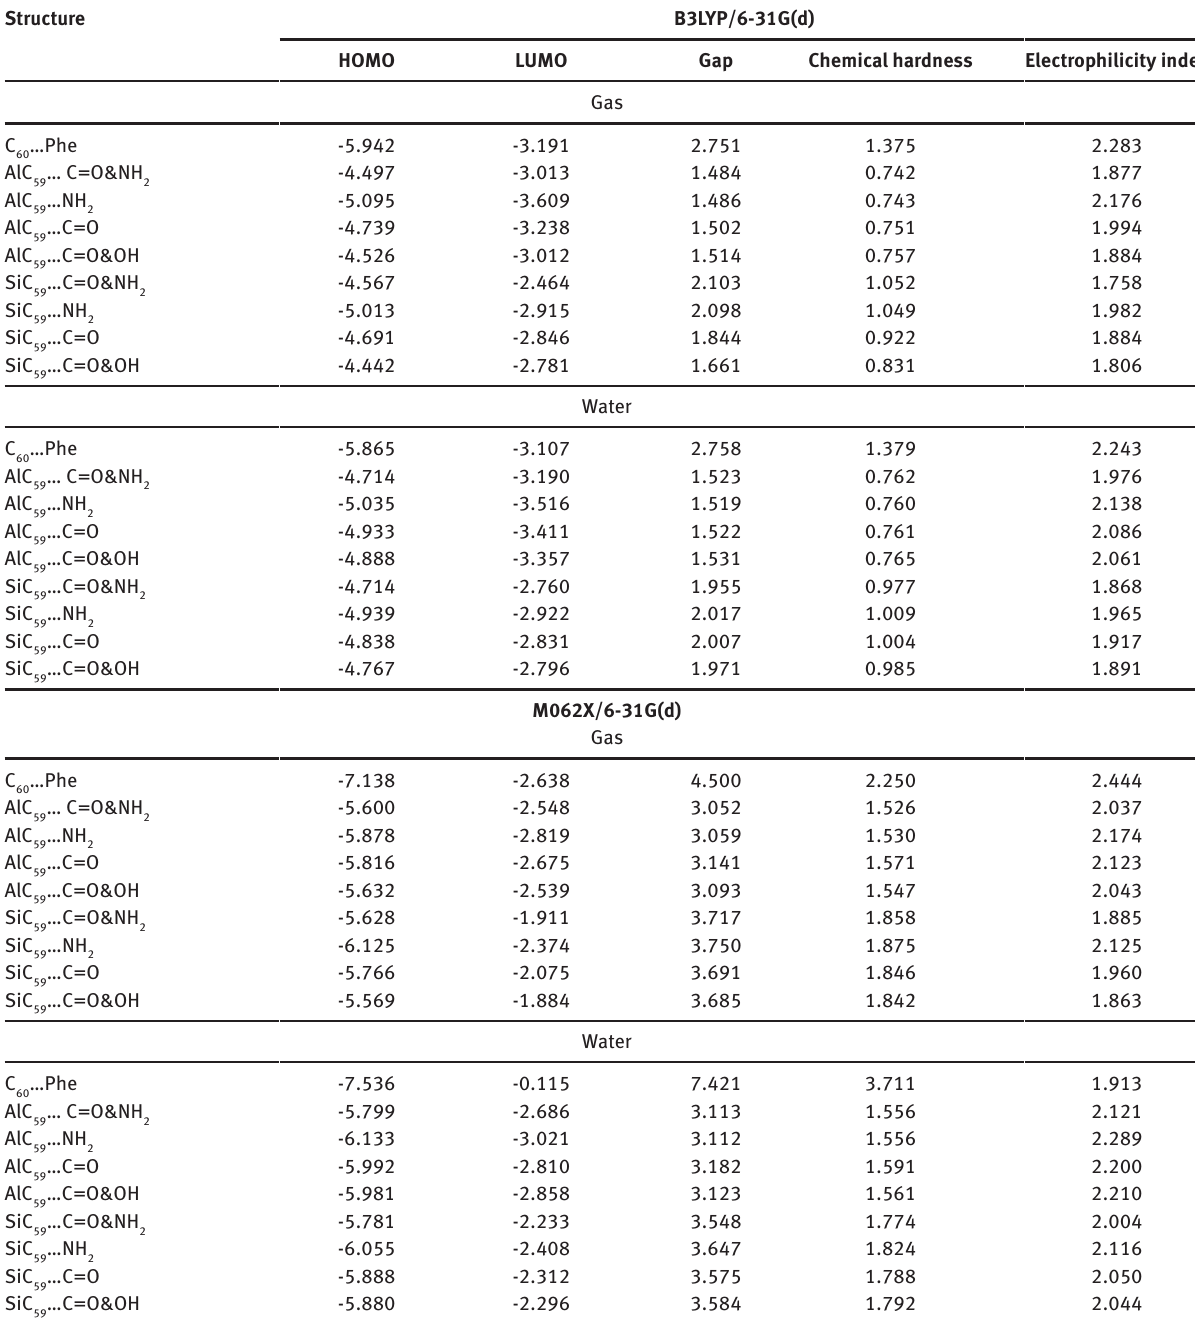
Table 2: Some energetic parameters (eV) of the investigated systems.